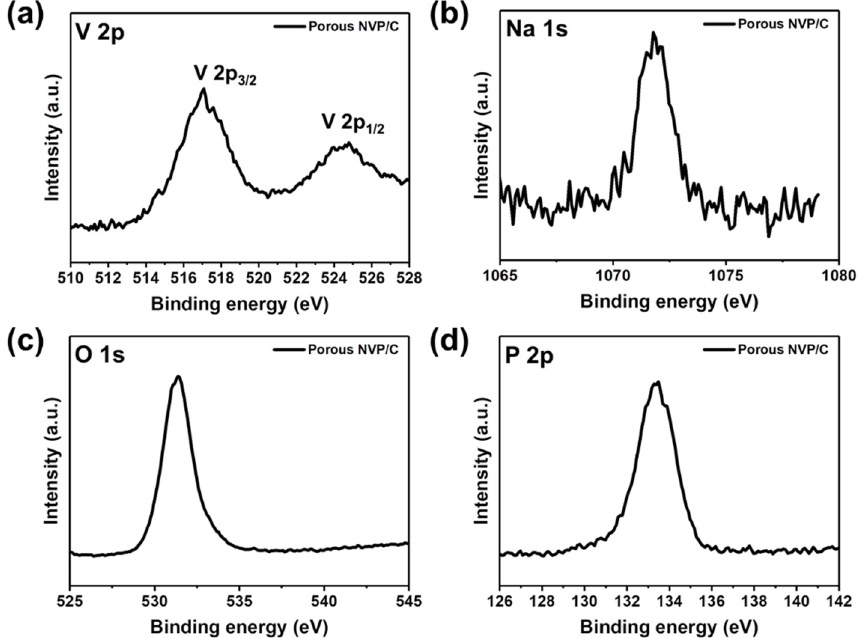
Figure 3. XPS spectra of the Porous NVP/C composites: ( a ) V 2p; ( b ) Na 1s; ( c ) O 1s; and ( d ) P 2p. The electrochemical properties of the two samples (NVP/C and Porous NVP/C composites) as cathode materials for NIBs were carried out in a voltage window of 2.7–4.2 V. It is worth noting that the redox reaction of both samples in the galvanostatic charge and discharge process was essentially related to the two-phase reaction between Na 3 V 2 (PO 4 ) 3 and NaV 2 (PO 4 ) 3 , as indicated by the well-formed plateau at ~3.4 V [18,24]. As mentioned earlier, the two sodium ions extraction and insertion from and into the structure are related to sodium ions that are occupying the M2 site, while the residual one sodium ion at the M1 site remained immobilized in the structure during electrochemical reactions. Therefore, the theoretical capacity of NVP materials was assumed to be ~117.8 mAh g − 1 according to the V 3+ /V 4+ redox reaction. As shown in Figure 4a, the measured discharge capacities of the NVP/C and Porous NVP/C composites at 0.1 C (1 C = 118 mA g − 1 ) were ~103 and ~110 mAh g − 1 , respectively. Interestingly, the discharge capacity of the Porous NVP/C composites was very close to the theoretical capacity. Considering that the TGA analysis results showed that the Porous NVP/C composite had a slightly lower NVP content, the higher capacity of the Porous NVP/C composite might be seem strange, because only NVP participated in the electrochemical reaction in the applied voltage window condition. As the carbonaceous species were not involved in electrochemical behaviors in the applied voltage window, the mass of carbon in the composite did not contribute to the capacity but rather was taken into account when calculating the specific capacity, thus easy to result in a decrease in the capacity. Therefore, the higher reversible capacity of the Porous NVP/C composite can be understood as a result of effective electron conduction and sodium ion transfer. As mentioned earlier, the carbon layer on the NVP particles was essential to improve electrical conductivity of the composites, but it also acted as an additional layer that hindered the movement of sodium ions.